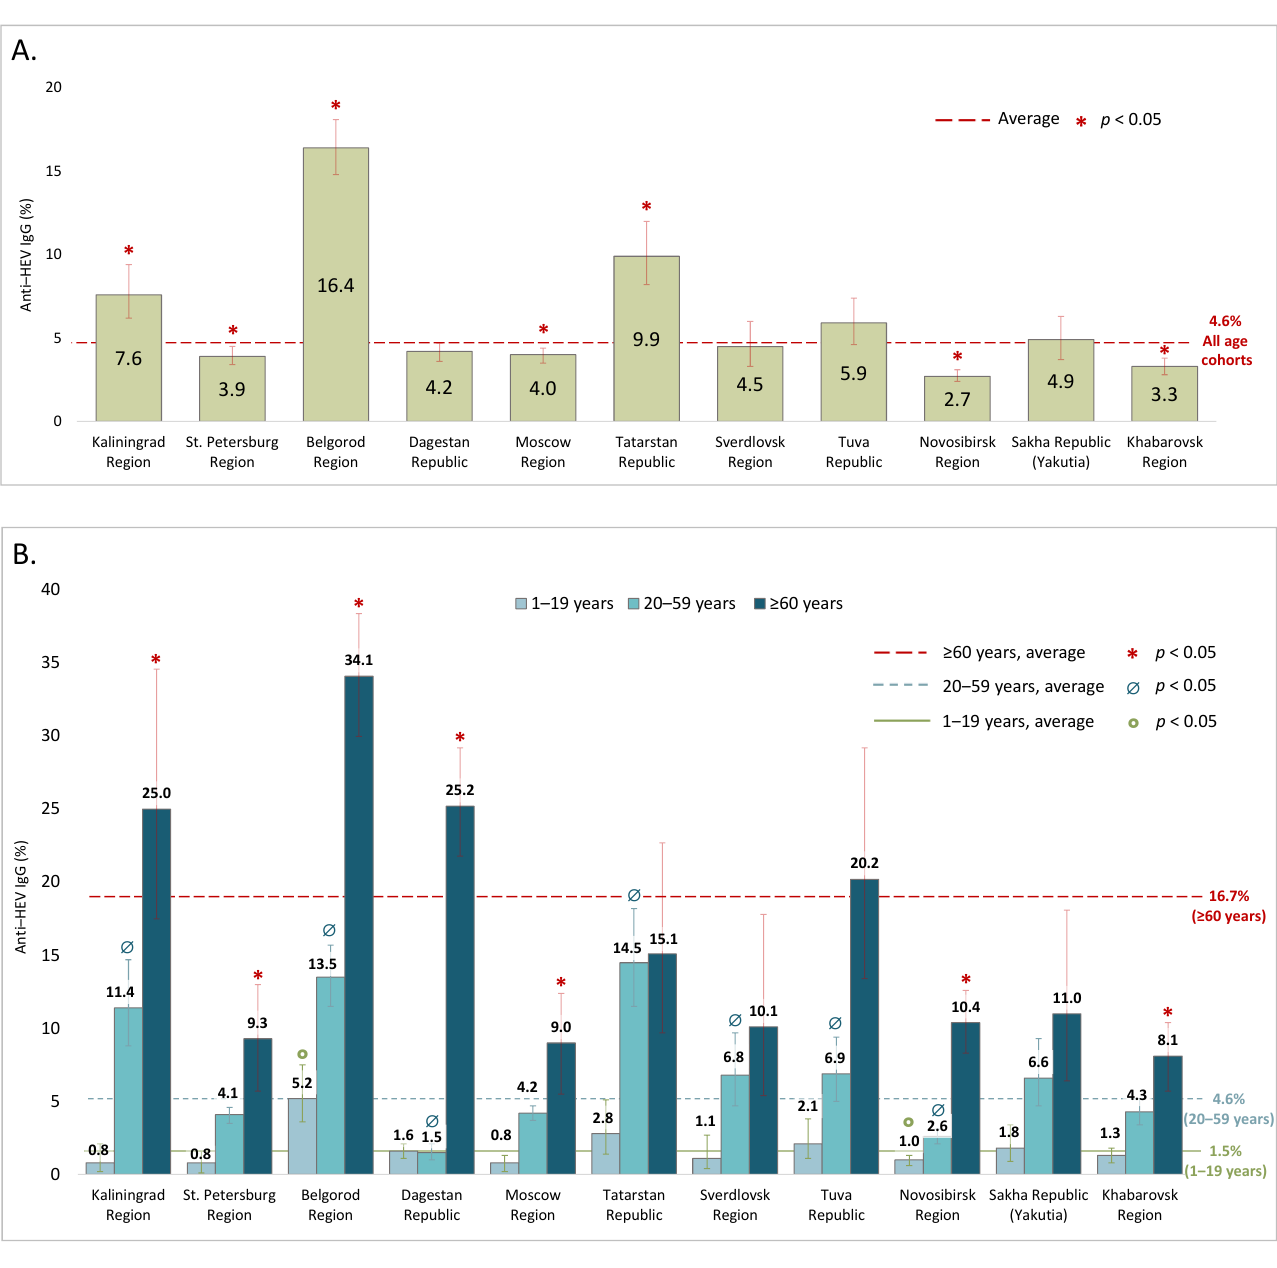
Figure 2. Anti-HEV IgG antibody average ( A ) and age-specific ( B ) prevalence rates among the general population in the regions studied in 2018–2020. National average and age-specific national average prevalence rates are shown with dashed lines. The statistically significant differences (chi-square with Yates correction) between regional data and national average or age-specific national average levels are shown with corresponding symbols. Error bars on the bar graphs represent 95% CI.